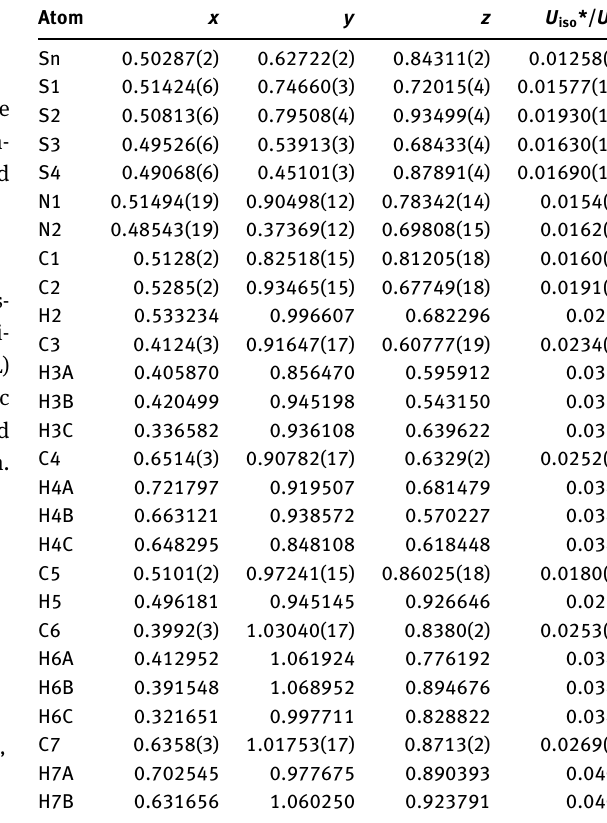
Table 2: Fractional atomic coordinates and isotropic or equivalent isotropic displacement parameters (Å 2